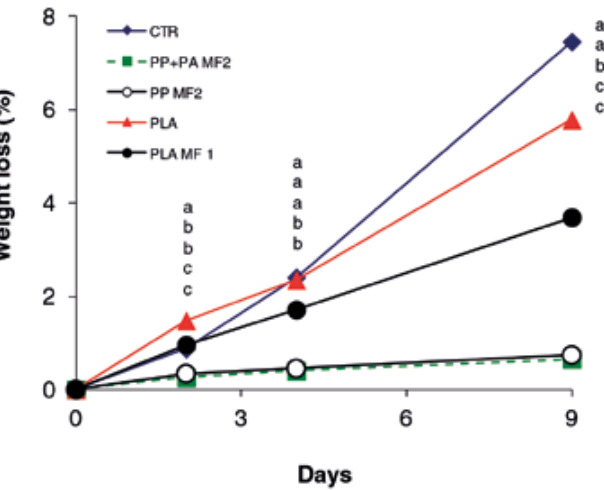
Fig. 4 - Ethanol and acetaldehyde accumulation, after 9 days of stor- age, in fresh-cut artichoke quarters packaged at 4°C in active +10% CO ), in different packag- modified atmosphere (5% O 2 2 ing conditions: PP+PAMF2 = polypropylene + polyamide with two lines of micro-perforations; PP MF2 = polypropilene with two lines of micro-perforations; PLA MF1 = polylactid acid with one line of micro-perforation; PLA = polylactic acid with- out micro-perforation. CTRL represents samples stored in air in macro-perforated bags. Mean values of three replicates ±